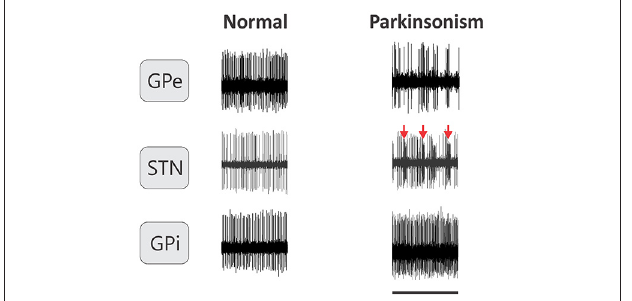
FIGURE 3 | Examples of extracellular recordings of individual neurons in the GPe, GPi and STN of monkeys in normal conditions and after MPTP treatment . Arrows indicate examples of bursts in an STN neuron. Horizontal line represents 1